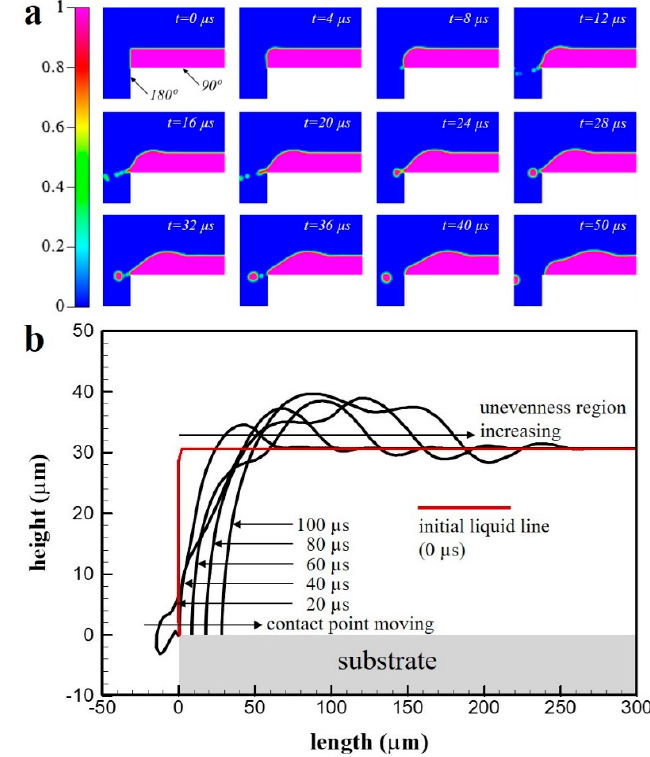
Figure 7. ( a ) Coating fluid behavior over time at the edge of the substrate under a substrate surface contact angle of 90° and a side contact angle of 180°. ( b ) Surface profile under different wetting conditions.